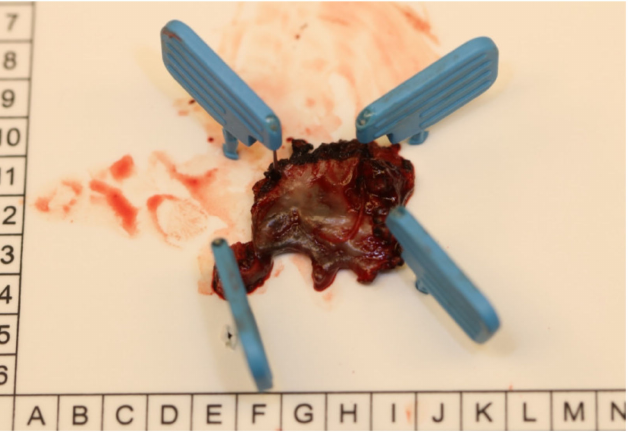
Figure 3. After resection, the specimen was oriented and fixed for histopathological examination. Three months later, another blackish change in the oral mucosa of approximately 2 × 2 mm in region 012 was noticeable (Figure 4).